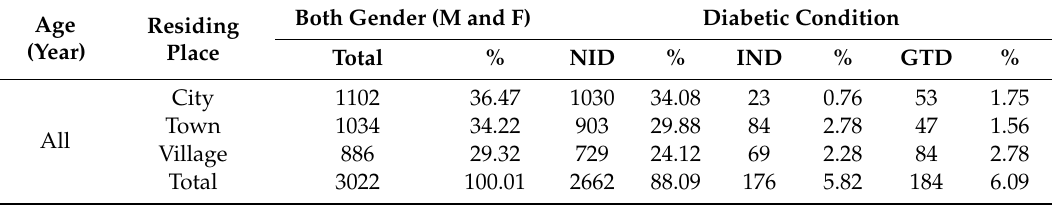
Table 3. The summary of the diabetes cases by age, gender, residing place and diabetic